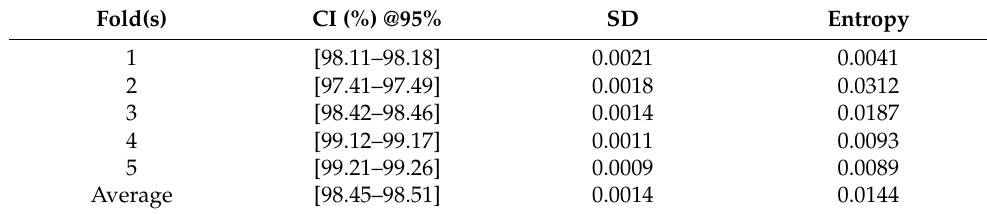
Table 6. Model uncertainty analysis outcome for